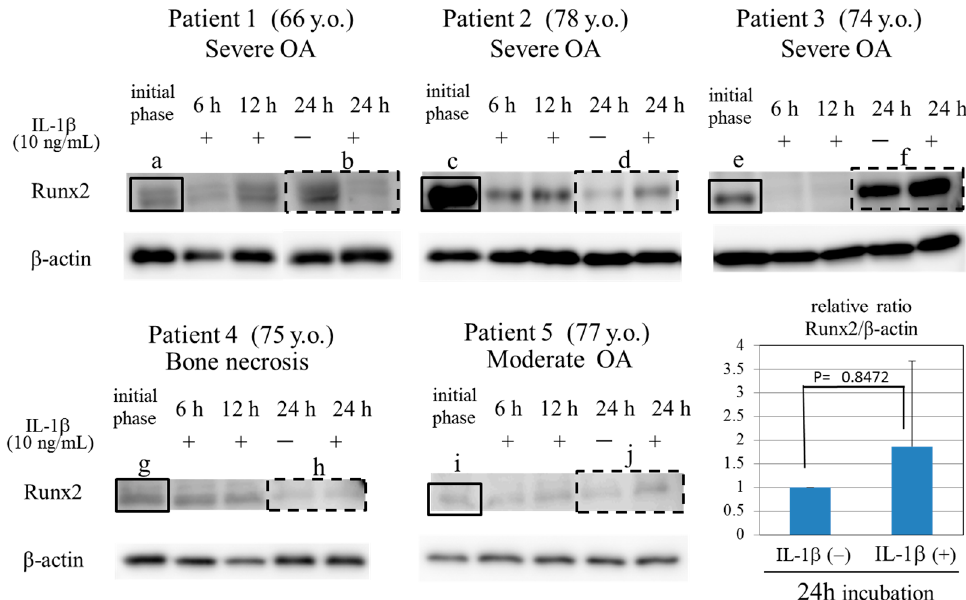
Figure 3. Effects of IL- β on Runx2 expression in osteoarthritic chondrocytes from donor patients. Time course of Runx2 expression in chondrocytes in the presence of IL-1 β (10 ng/mL). At the initial phase, the level of Runx2 expression in chondrocytes was higher in patients with severe OA (Patient 1 ( a ), Patient 2 ( c ), and Patient 3 ( e )) than in patient with bone necrosis (Patient 4 ( g )) and patient with moderate OA (Patient 5 ( i )). After 24 h-incubation period, the expression level of Runx2 increased in the presence of the IL-1 β (10 ng/mL) in chondrocytes from Patient 2 ( d ), Patient 3 ( f ), Patient 5 ( j ) but not Patient 1 ( b ) and Patient 4 ( h ), although its expression levels decreased transiently at 6 and 12 h incubation periods. Solid box indicates the expression of Runx2 at the initial phase. The dash line box indicates the expression of Runx2 at 6 and 12 h incubation periods. The treatment with IL-1 β trended to induce the expression of Runx2, although no significant difference was observed between the IL-1 β -treated group and the control group.